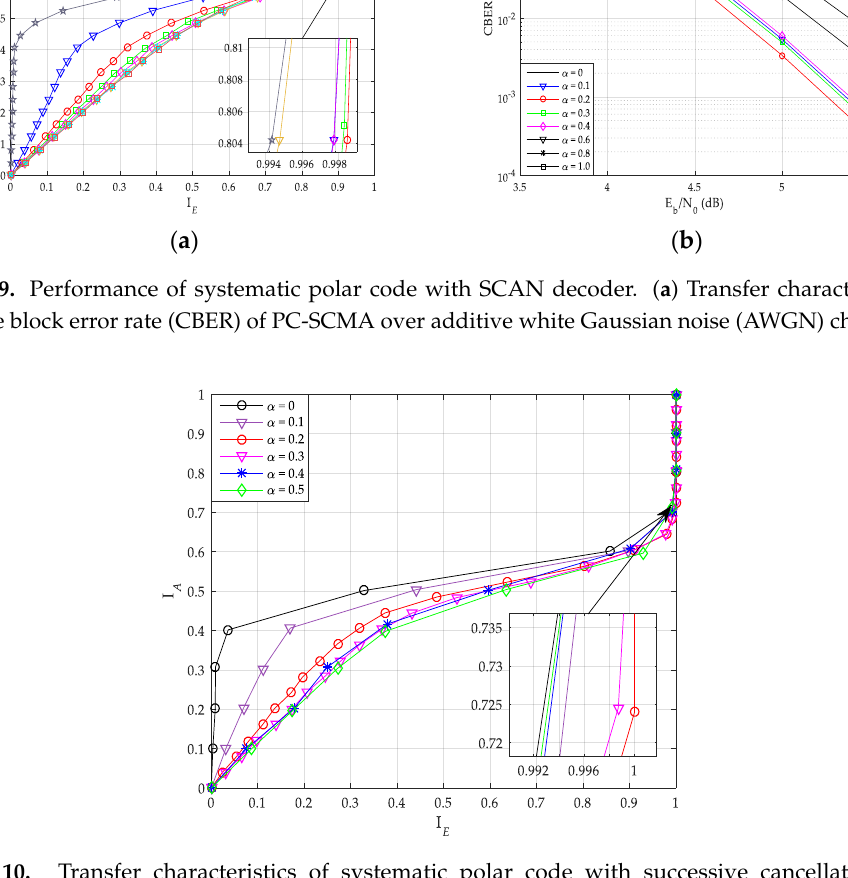
( b ) Figure 11. Transfer characteristics of PIC PCCA-polar code with different  . ( a ) K = 100, R = 1/2; ( b ) K = 64, R = 1/3. Based on the previous optimization results, Figure 12 shows the transfer characteristics of PIC polar codes and uncoupled polar codes. The performance of uncoupled polar code with SCAN decoder is worst among other codes. At the same time, the performance of PIC PCCA-polar code is the best. Additionally, when the input mutual information is small, code blocks that are coupled to each other cannot exchange correct extrinsic messages, the output mutual information of PIC polar code (whether it’s PCCA-based or CA-based) is smaller than that of the uncoupled polar code.